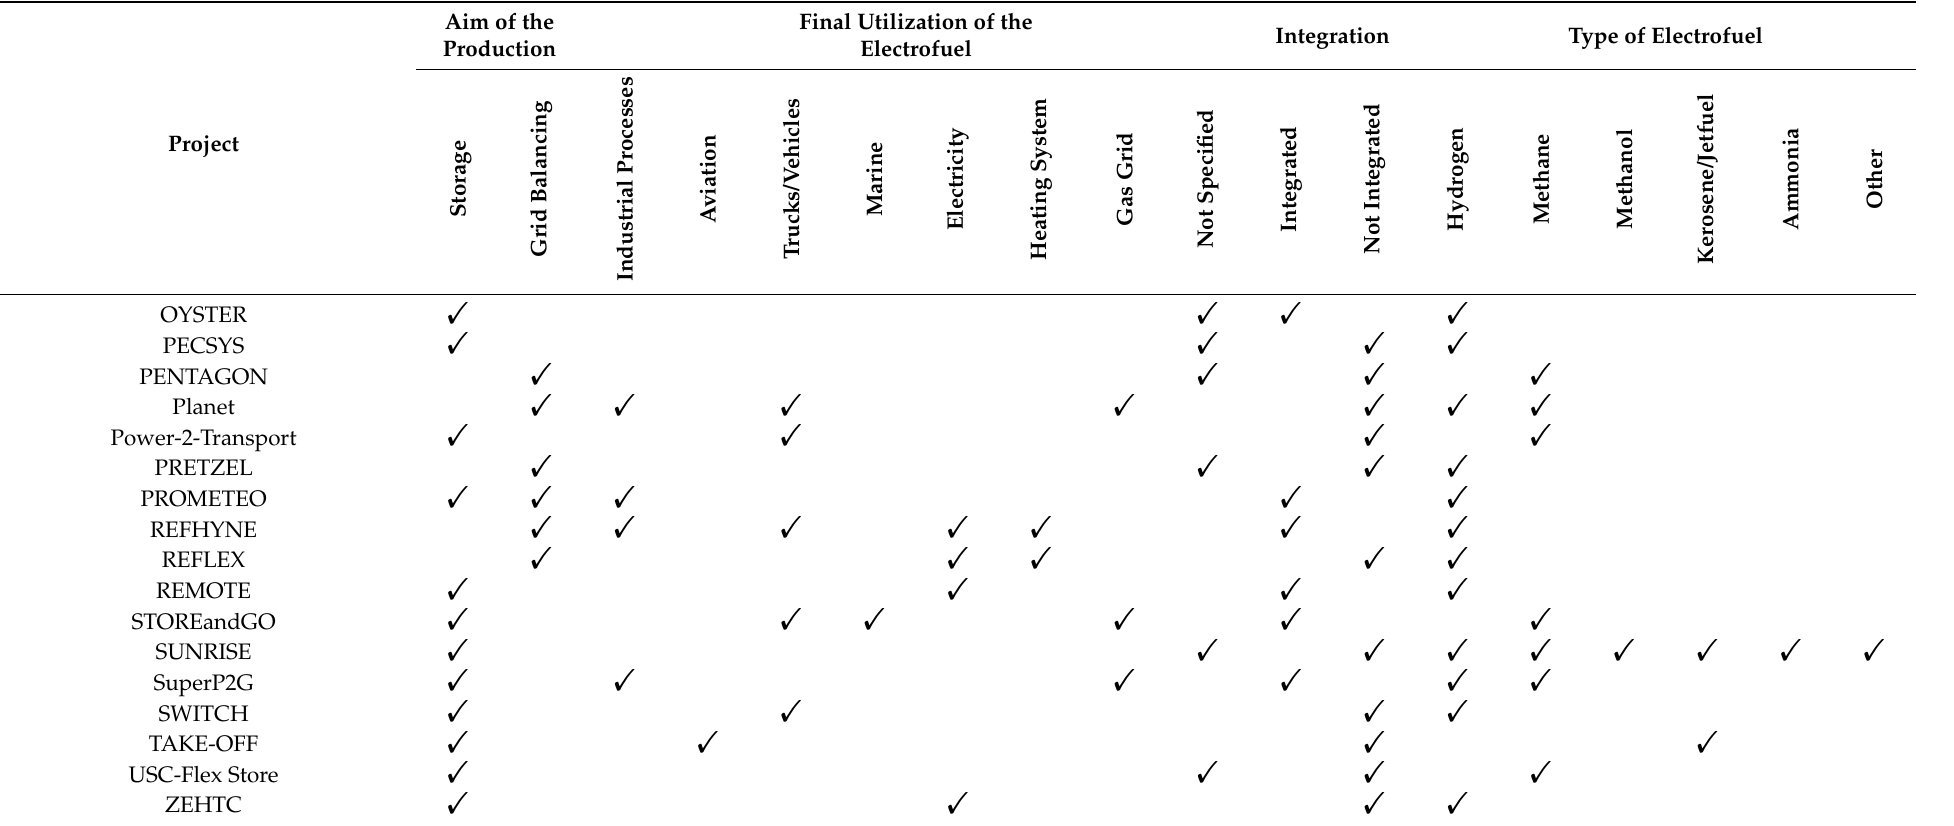
Table A2. Cont. Aim of the Production